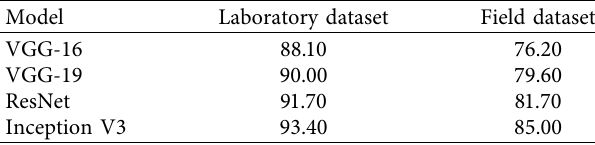
Table 3: Classification accuracy using feature extraction.